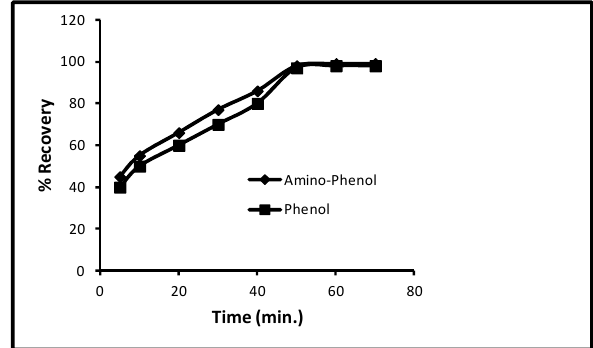
Figure 6. Effect of desorption time for phenols.